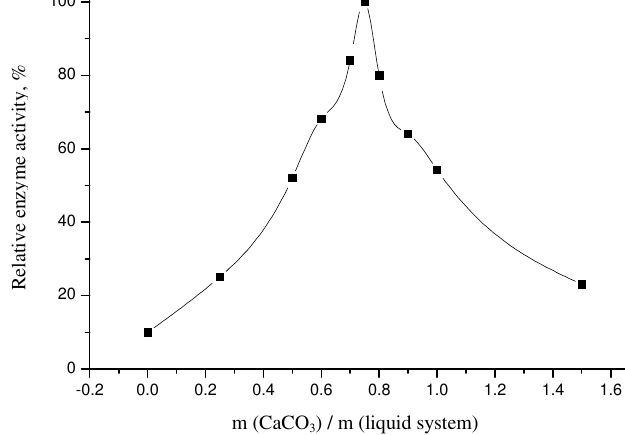
Figure 1. Effect of enzyme activity bounded on the